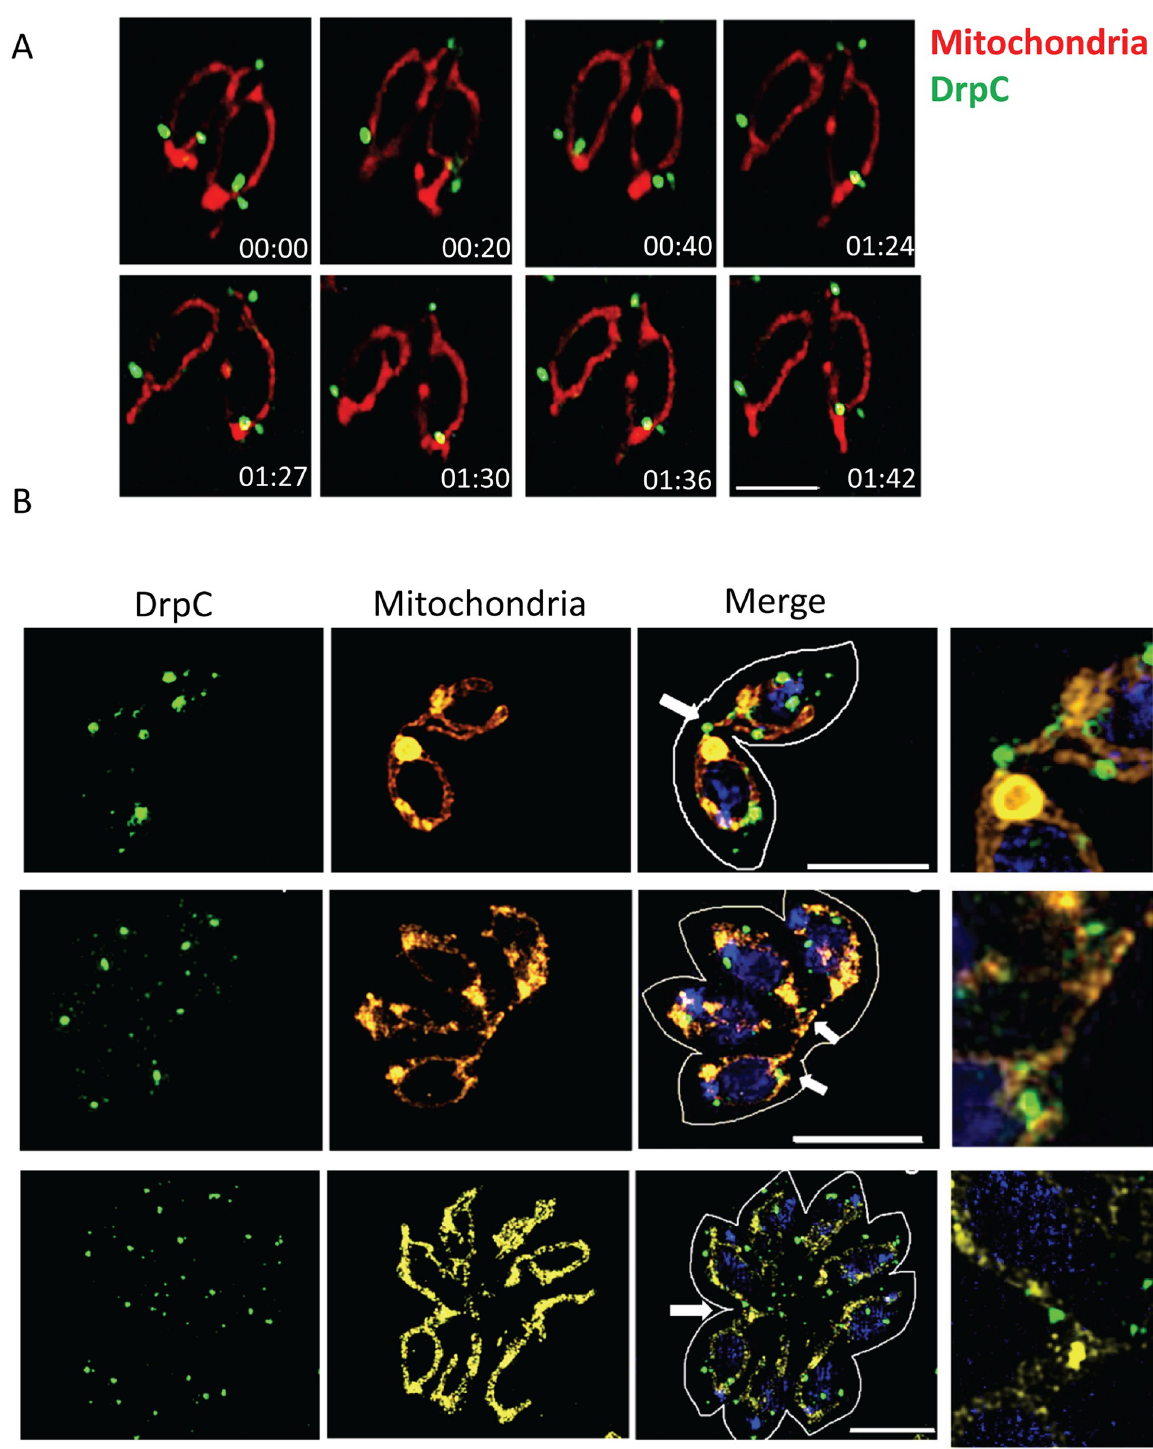
Fig 4. Recruitment of Tg DrpC at interconnected mitochondria during replication. (A) Time-lapse analysis of parasites Tg DrpC-YFP/ TGME49_215430-tdTomato with interconnected mitochondria (in red, TGME49_215430-tdTomato; in green, Tg DrpC-YFP). Tg DrpC is at the mitochondria periphery and at the basal interconnection; while the puncta at the periphery are more static, the signal at the basal end is highly dynamic. Time is indicated in minutes. Scale bar: 5 μ m. (B) SIM microscopy shows that the puncta at the basal end coincide with sites of constriction of the MOM (white arrows). Scale bar: 5 μ